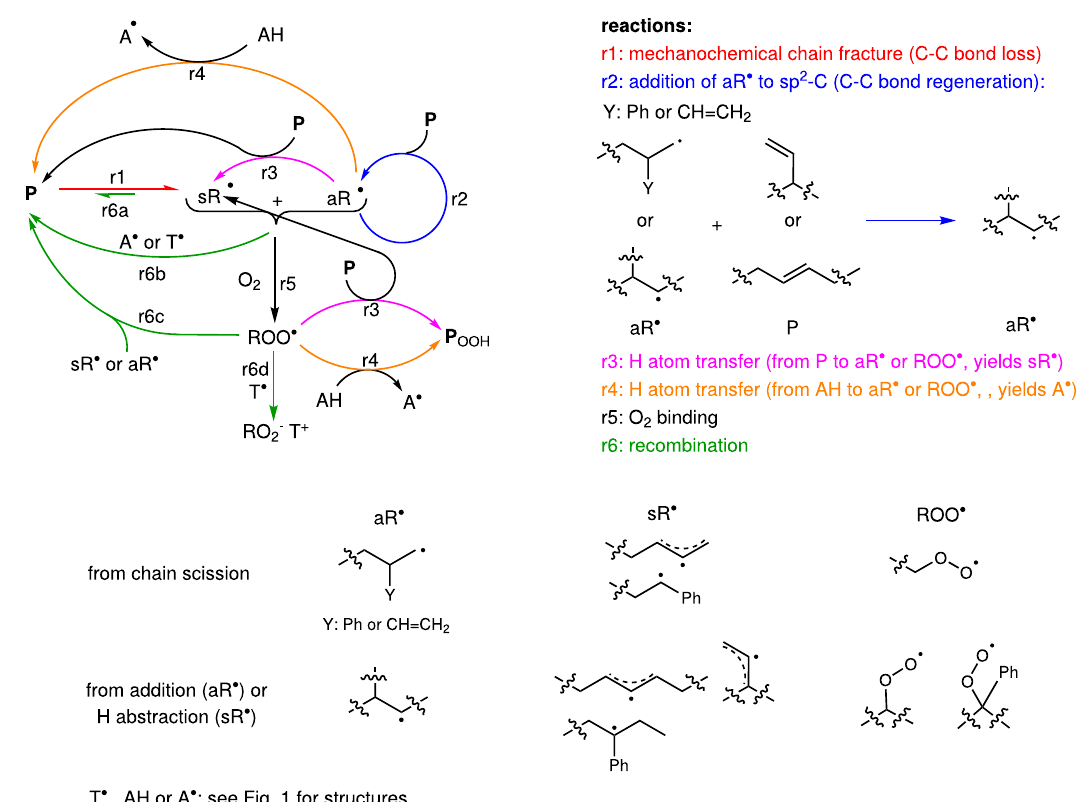
Fig. 3 The simplest mechanism of low-temperature mechanochemical remodeling of neat and doped copolymer under N 2 and air. P is any closed-shell copolymer chain regardless of microstructure, size or functional